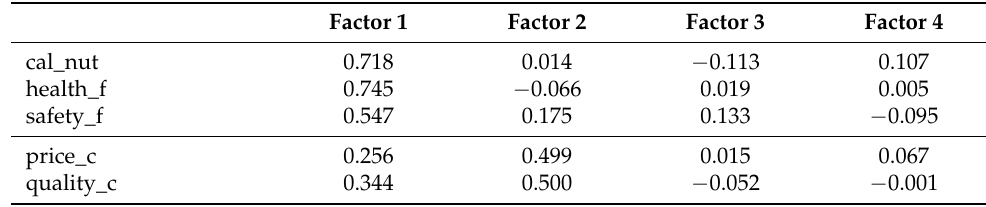
Table 2. Factor analysis of